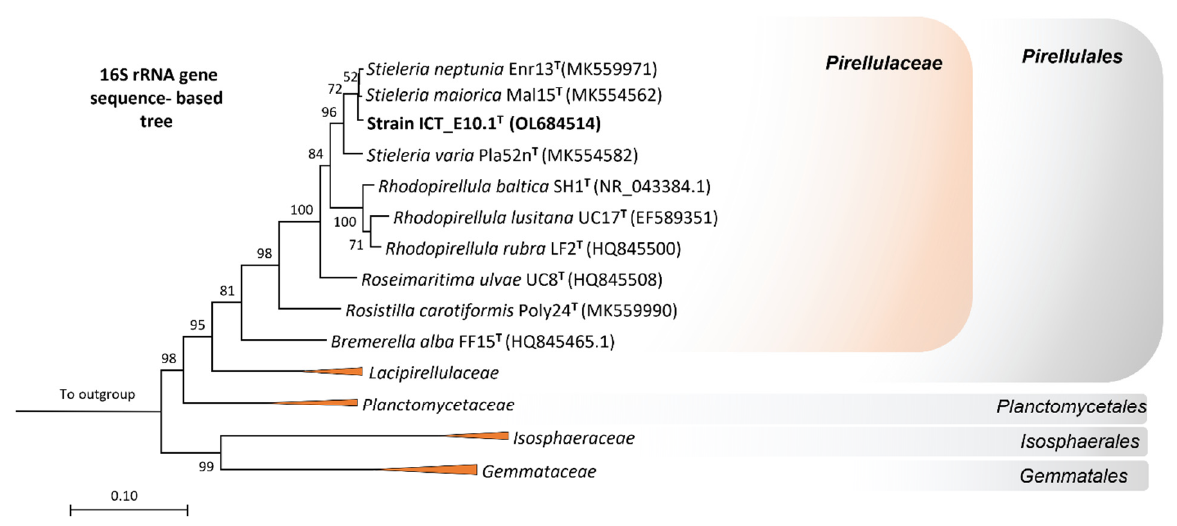
Figure 1. Phylogeny of strain ICT_E10.1 T through the analysis of the 16S rRNA gene sequence. The maximum-likelihood tree evidences the proximity of strain ICT_E10.1 T to the genus Stieleria within the family Pirellulaceae of the bacterial phylum Planctomycetota . GenBank sequence identifiers of other type strains are shown in parentheses. One thousand bootstraps were applied, and the respective values given at the nodes (in %). Branches of the other families in the class Planctomycetia collapsed at the family level. Three strains from the phylum Verrucomicrobiota were utilized as